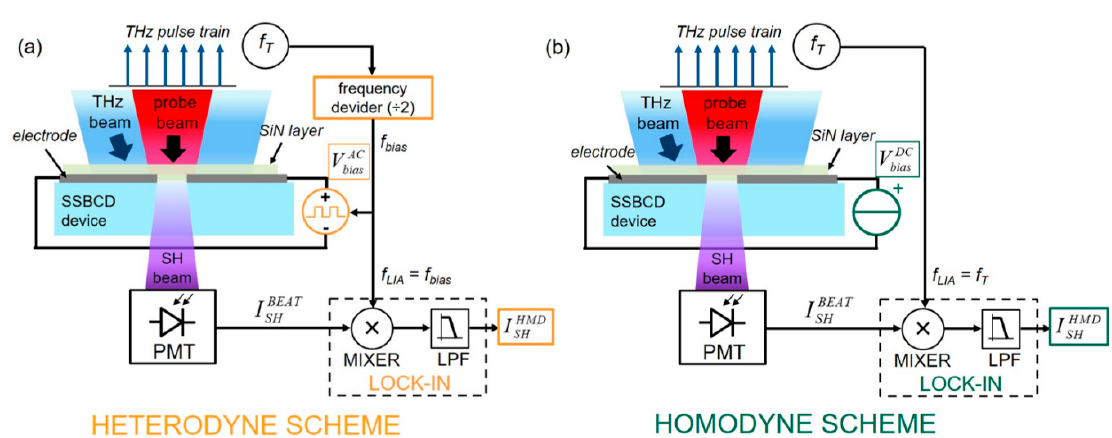
Figure 1. Block diagrams of the solid-state-biased coherent detection (SSBCD) scheme operated via ( a ) a heterodyne and ( b ) a homodyne detection configuration. ( a ) Heterodyne SSBCD: an electronic circuit (orange block) divides by two the THz pulse repetition rate ( f LO = f T /2) and accordingly generates an AC square wave bias voltage (orange circle), phase-locked to f T , feeding the SSBCD device. An electrical signal synchronous to f LO is mixed with the PMT electrical readout I BEAT and then is filtered out through a low-pass filter (LPF), so to extract the heterodyne signal I HTD . Both mixer and LPF are fundamental blocks inside a lock-in amplifier. ( b ) Homodyne SSBCD: a DC bias voltage (green circle) is independently generated by a common power supply. The mixer is fed with a reference signal synchronized to f T , returning a signal in the base band, filtered out through an LPF, which only acts as a noise attenuation